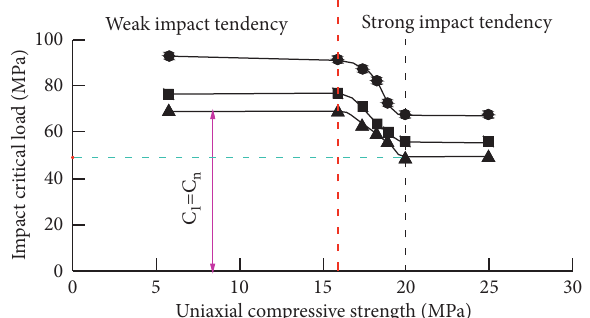
Figure 11: Relationship between strength of coal pillar and C